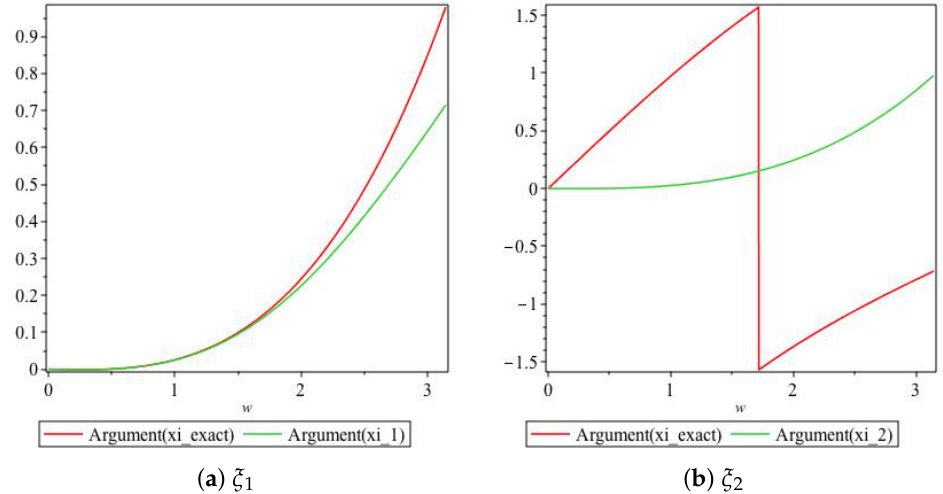
Figure 10. Plot of the arguments of amplification factors of Scheme 2 for Numerical Experiment 1 with spatial and temporal step sizes h = π /10 and k = 0.001,